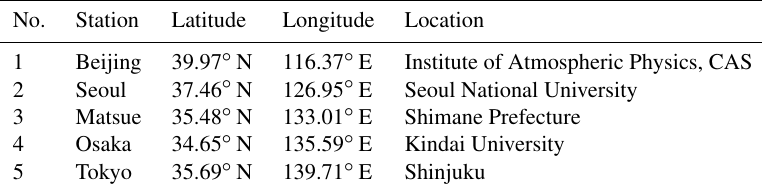
Table 2. List of lidar observation stations in this study. No. Station Latitude Longitude